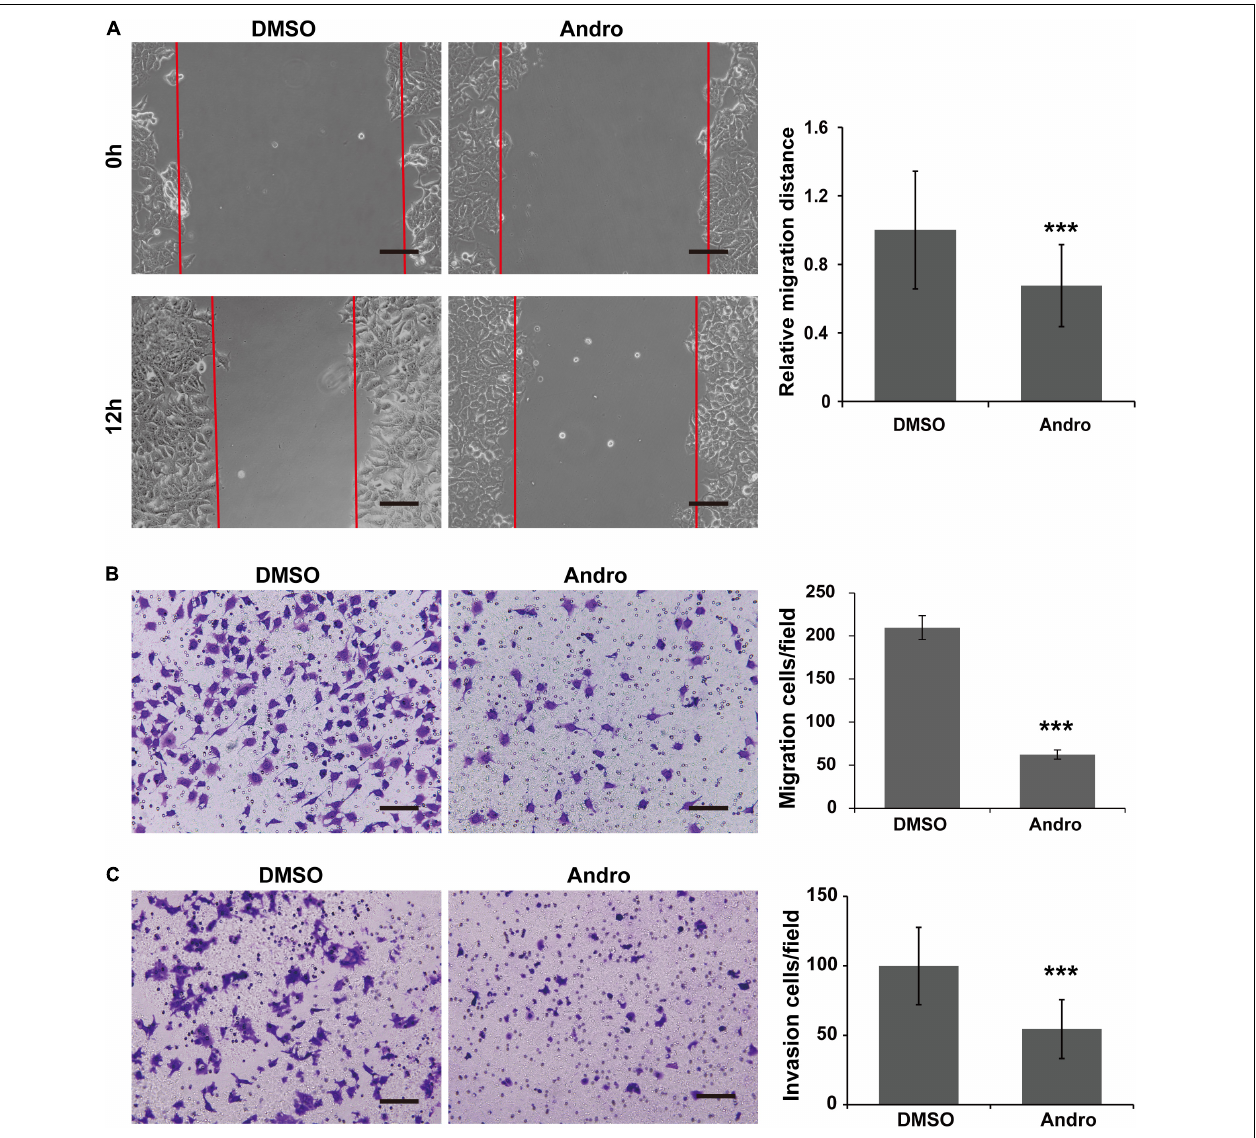
FIGURE 5 | Andrographolide (Andro) inhibits migration and invasion of MCF-7 cells. (A) Wound healing assay for MCF-7 cell migration. Transwell assay for the migration (B) and invasion (C) potential of MCF-7 cells. Quantitative data are expressed as the mean ± SD ( n = 3). Significant effect: *** P < 0.001. Scale bar , 100 µ